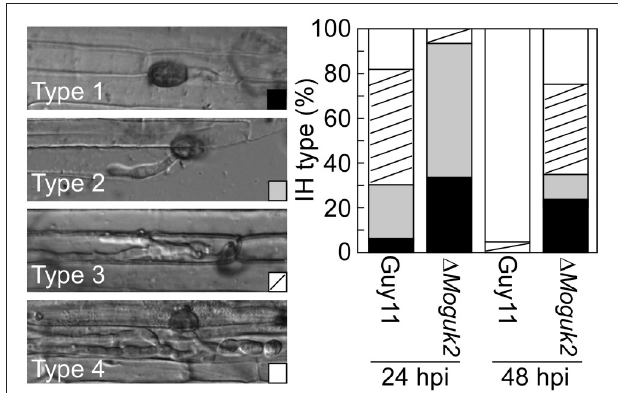
FIGURE 7 | The 1 Moguk2 mutant was defective in infectious hyphal growth. Statistical analysis of the percentage of infectious hyphae (IH) types in rice sheath cells at 24 and 48 hpi (type 1: no infectious hyphae; type 2: one infectious hyphae; type 3: two or three branches restricted in one cell; type 4: more than three branches extended to a neighboring cell; N =